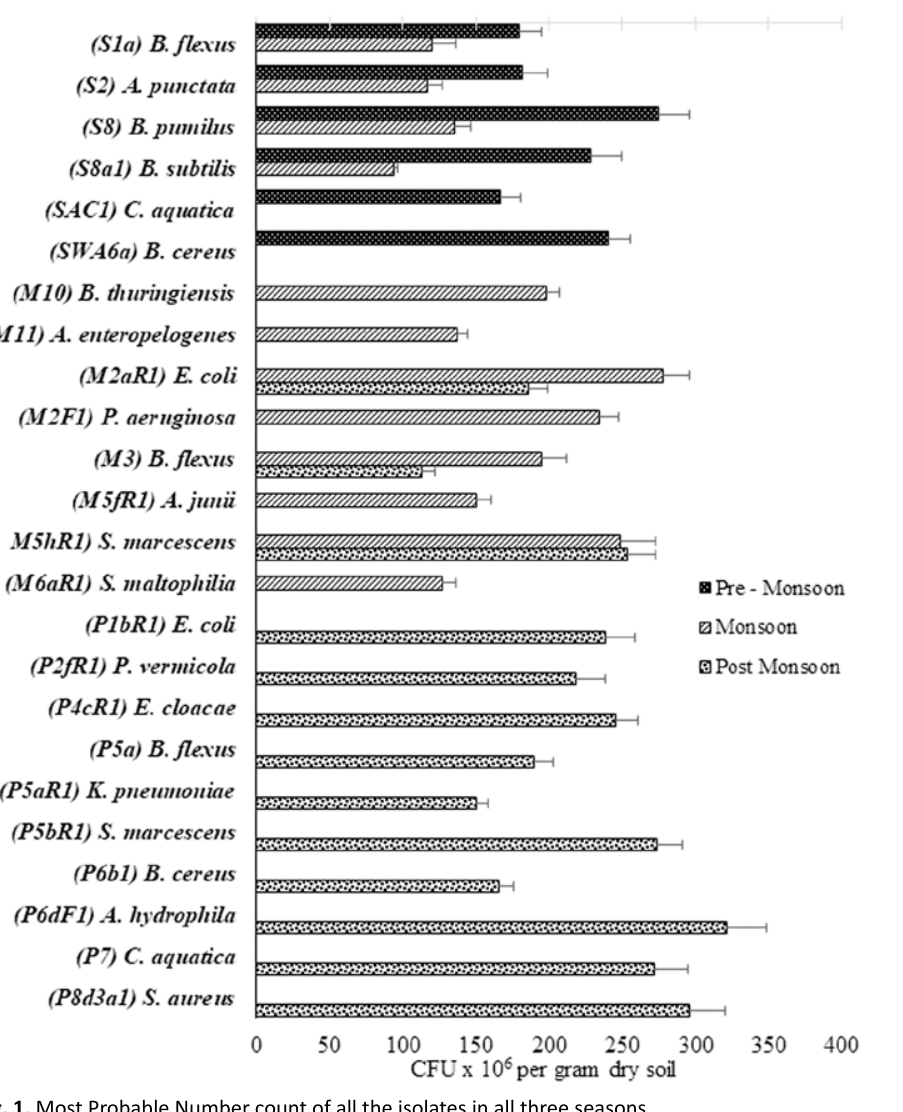
Fig. 1. Most Probable Number count of all the isolates in all three